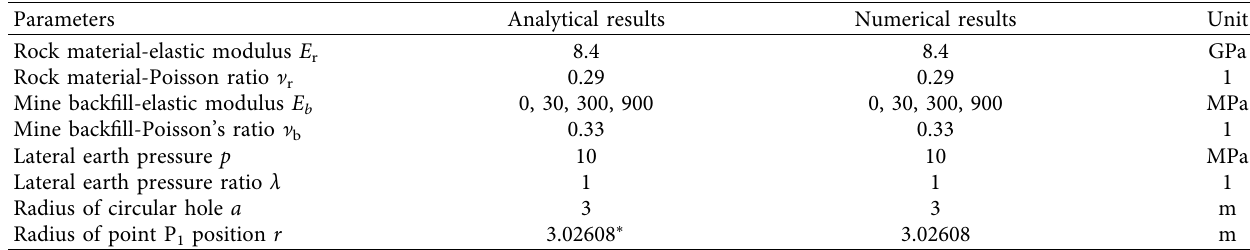
Figure 5: Numerical model of creep behavior of nearby rock material under the filling support effect (P1 is the extracted comparison data point). Table 1: Input parameters of the numerical model and analytical